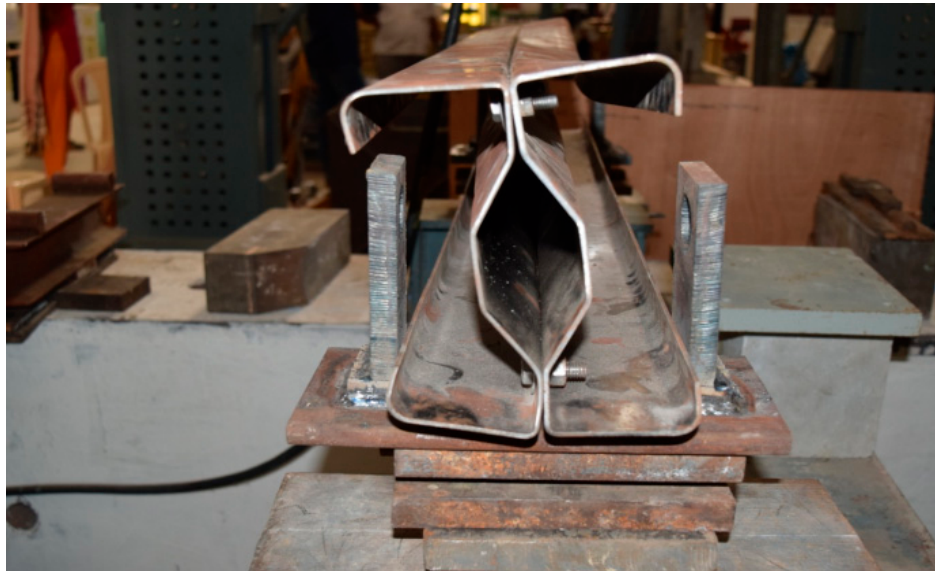
Figure 9. Failure mode B2B100.